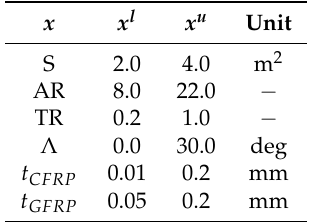
Table 1. Design space